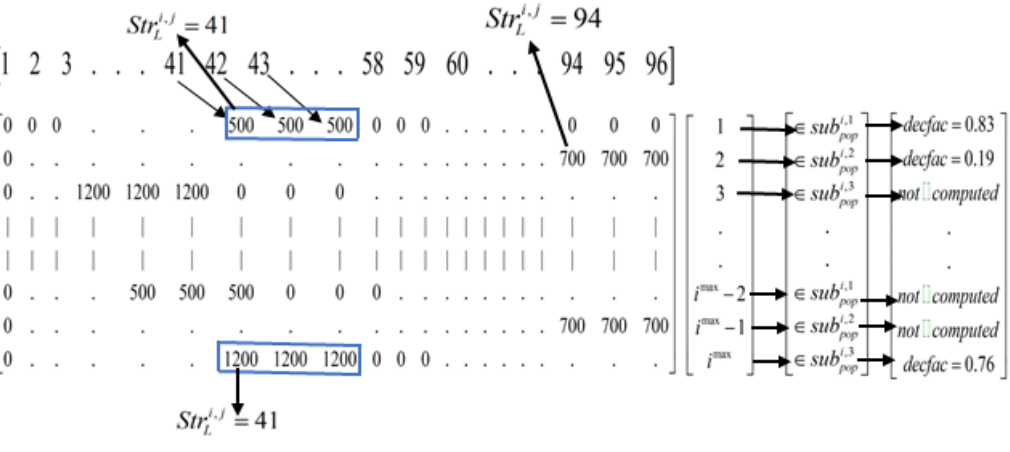
Figure 6. DSM j load allocation in pop i based on str i , j